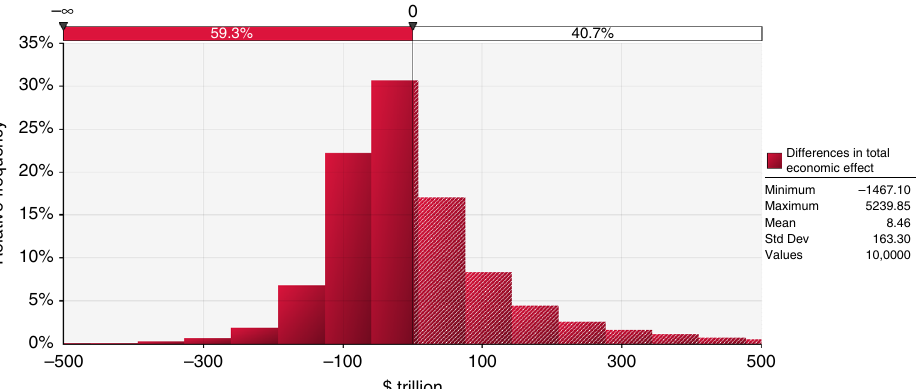
Fig. 6 Simulated difference between the total economic effects of climate change under the 2 °C and 1.5 °C scenarios. Probability density function (relative frequency) of the difference between the total economic effects of climate change for the 2 °C and 1.5 °C target scenarios with the nonlinear PCF & SAF. Horizontal axis units: $trillion, NPV until 2300, equity-weighted, PTP-discounted. 100,000 Monte-Carlo runs of PAGE-ICE. Source data are provided as a Source Data fi le